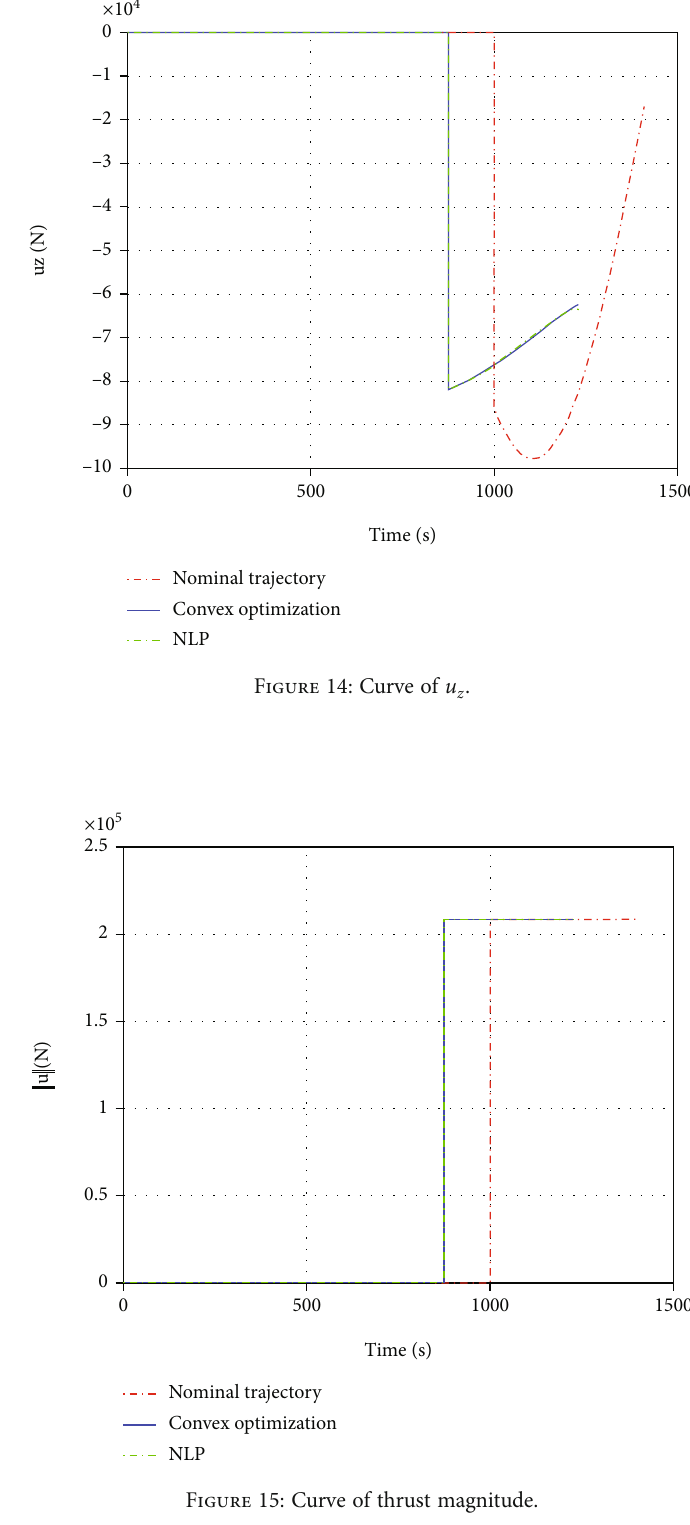
Figure 15: Curve of thrust